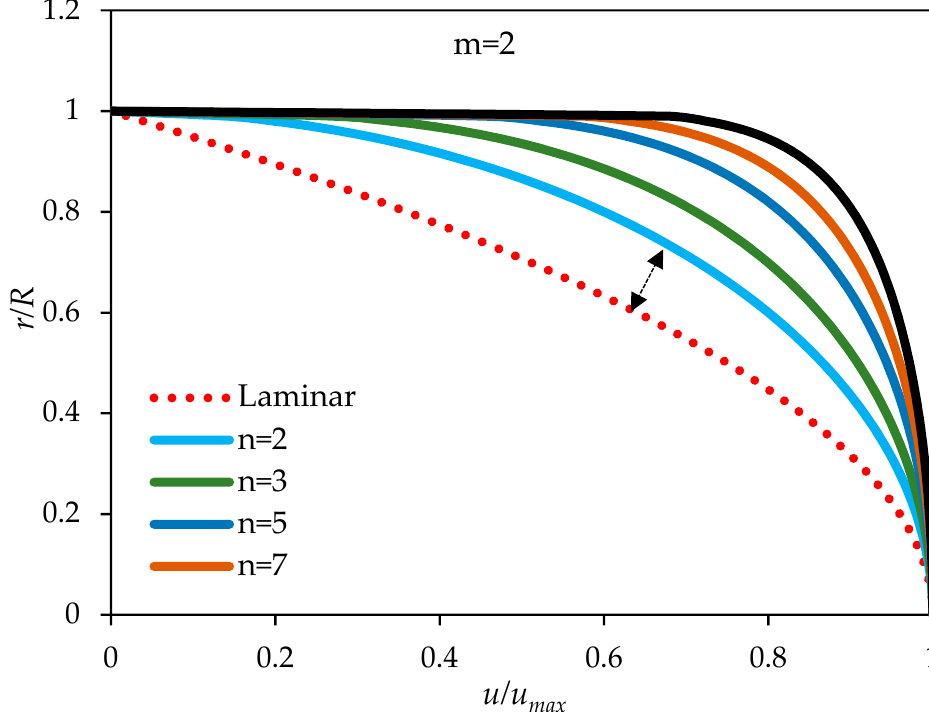
Figure 6. Normalized velocity profiles for different n when m = 2.